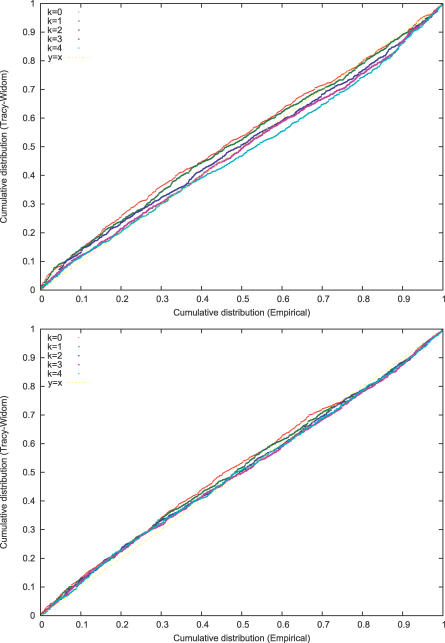
LD Correction with no LD PresentP–P plots of the TW statistic, when no LD is present and after varying levels (k) of our LD correction. We first show this (A) for m = 500, n = 5,000, and then (B) for m = 200, n = 50,000. In both cases the LD correction makes little difference to the fit.